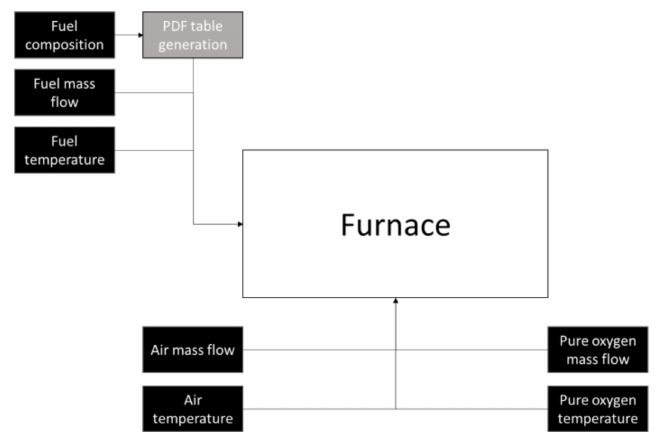
Figure 6. Schematic of the boundary conditions